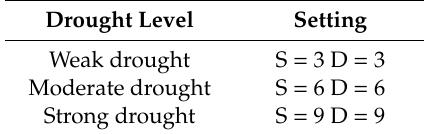
Table 2. Drought level parameters according to the criteria of Wang et al,